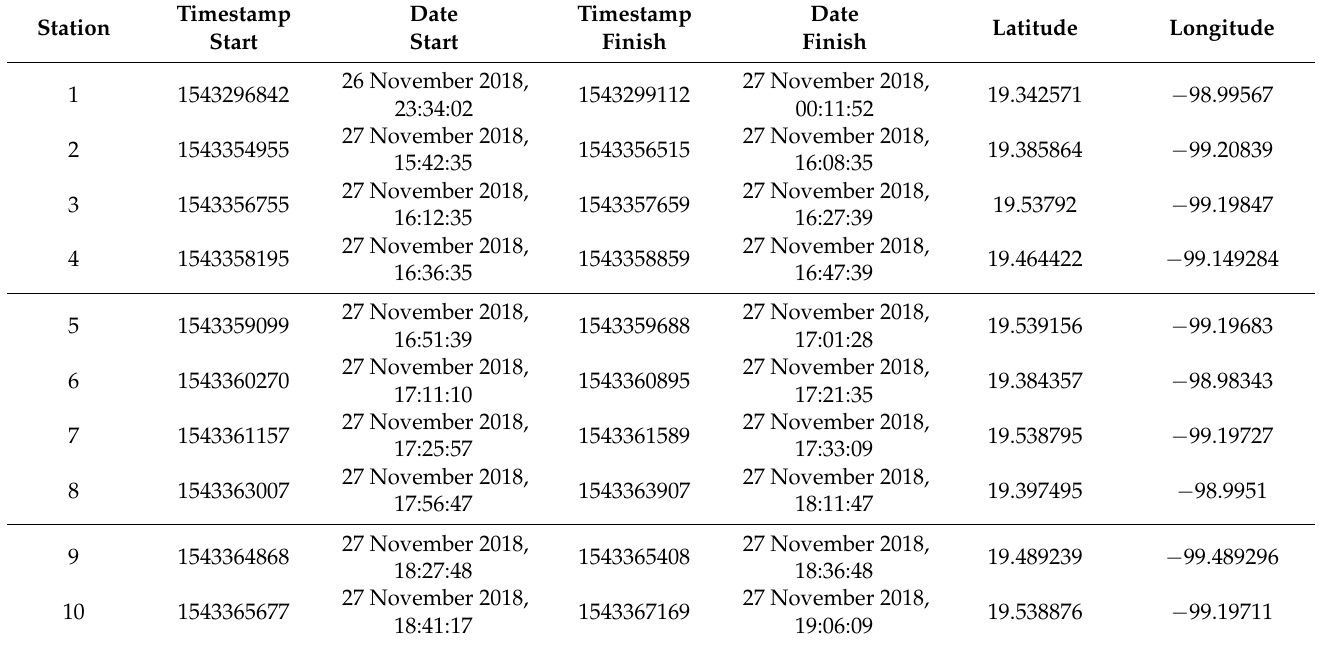
Table 2. Example of the format of the processed